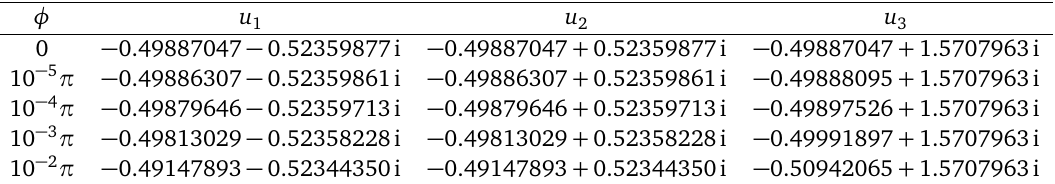
Table 2: Numerical results for the Bethe roots of the Bethe vector |{ u }〉 as a small twist φ is turned ing |{ α FM 1